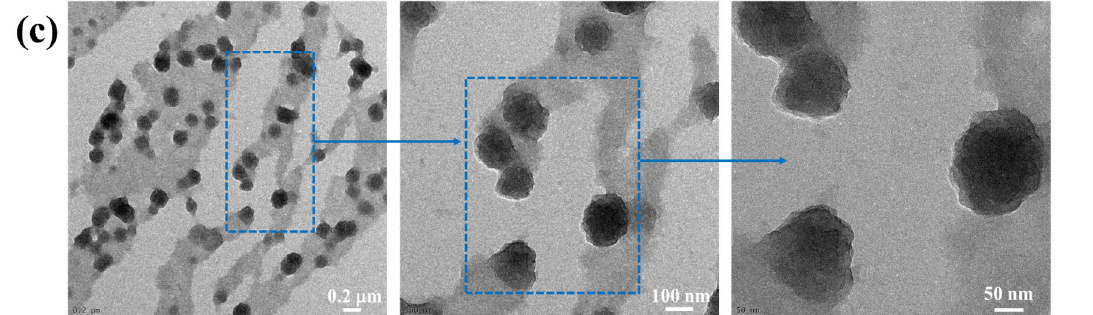
Figure 1. ( a ) FTIR spectra, ( b ) DLS average hydrodynamic size of FCPDA nanoparticles, and ( c ) TEM images of FCPDA nanoparticles.